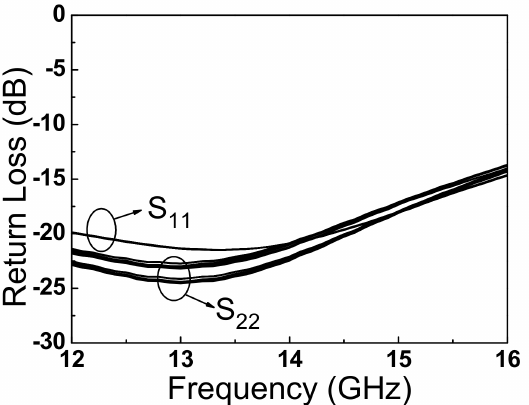
Figure 11. Measured return losses of the Ku-band CMOS transmit and receive IC.